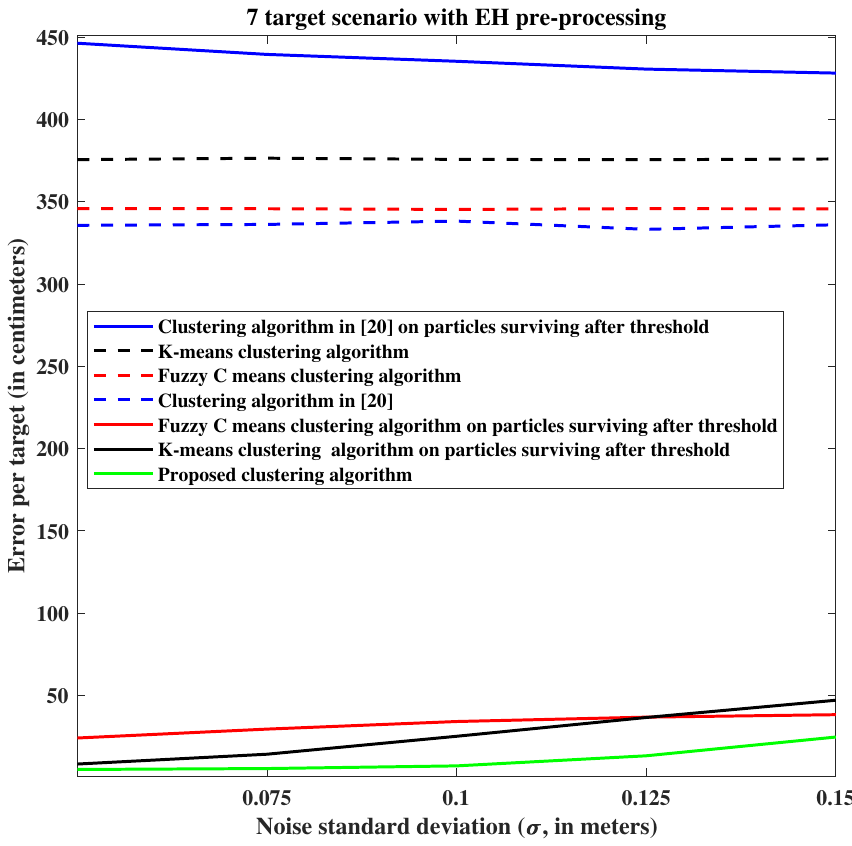
Figure 7. Performance comparison with proposed ellipse-histogram (EH)